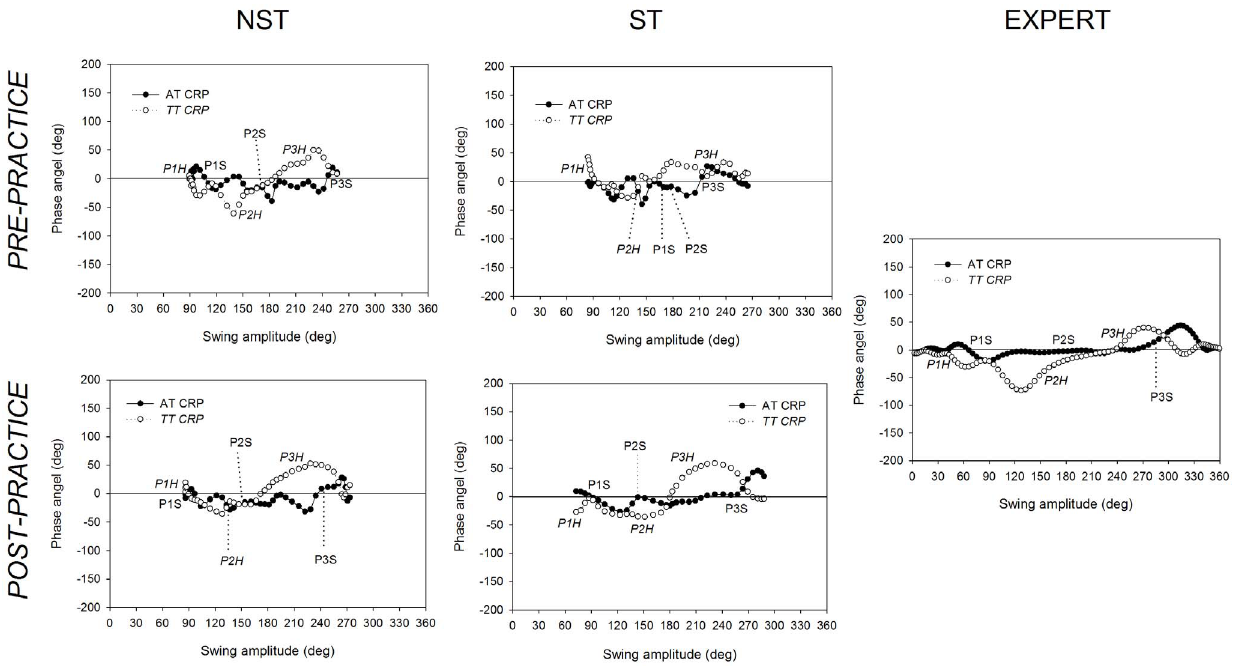
Figure 3. Continuous relative phases obtained from one participant in each group before and after the practice. Representative continuous relative phases (CRP) of the arm-trunk (AT) and trunk-thigh (TT) coordination obtained from one participant in each novice group (spontaneously-talented, ST, and non-spontaneously-talented, NST) and expert group when they performed a longswing on high bar. CRPs acquired before and after the practice period (pre- and post-practice, respectively) are depicted for the ST and NST groups.